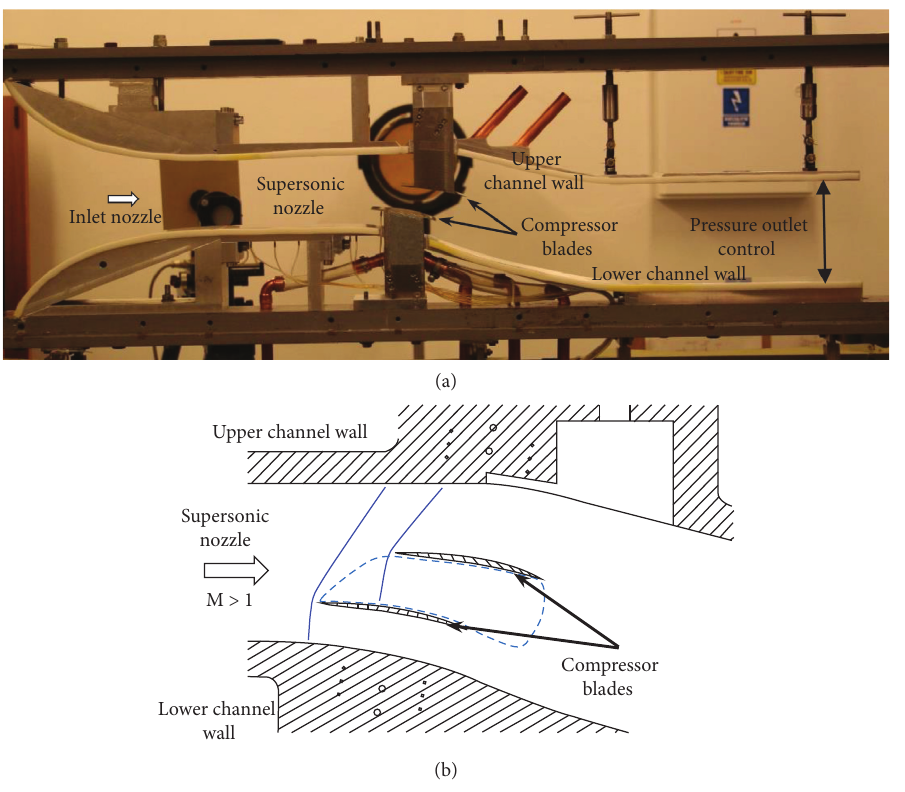
Figure 1: (a) View of the test section in the transonic wind tunnel. (b) Test section layout.